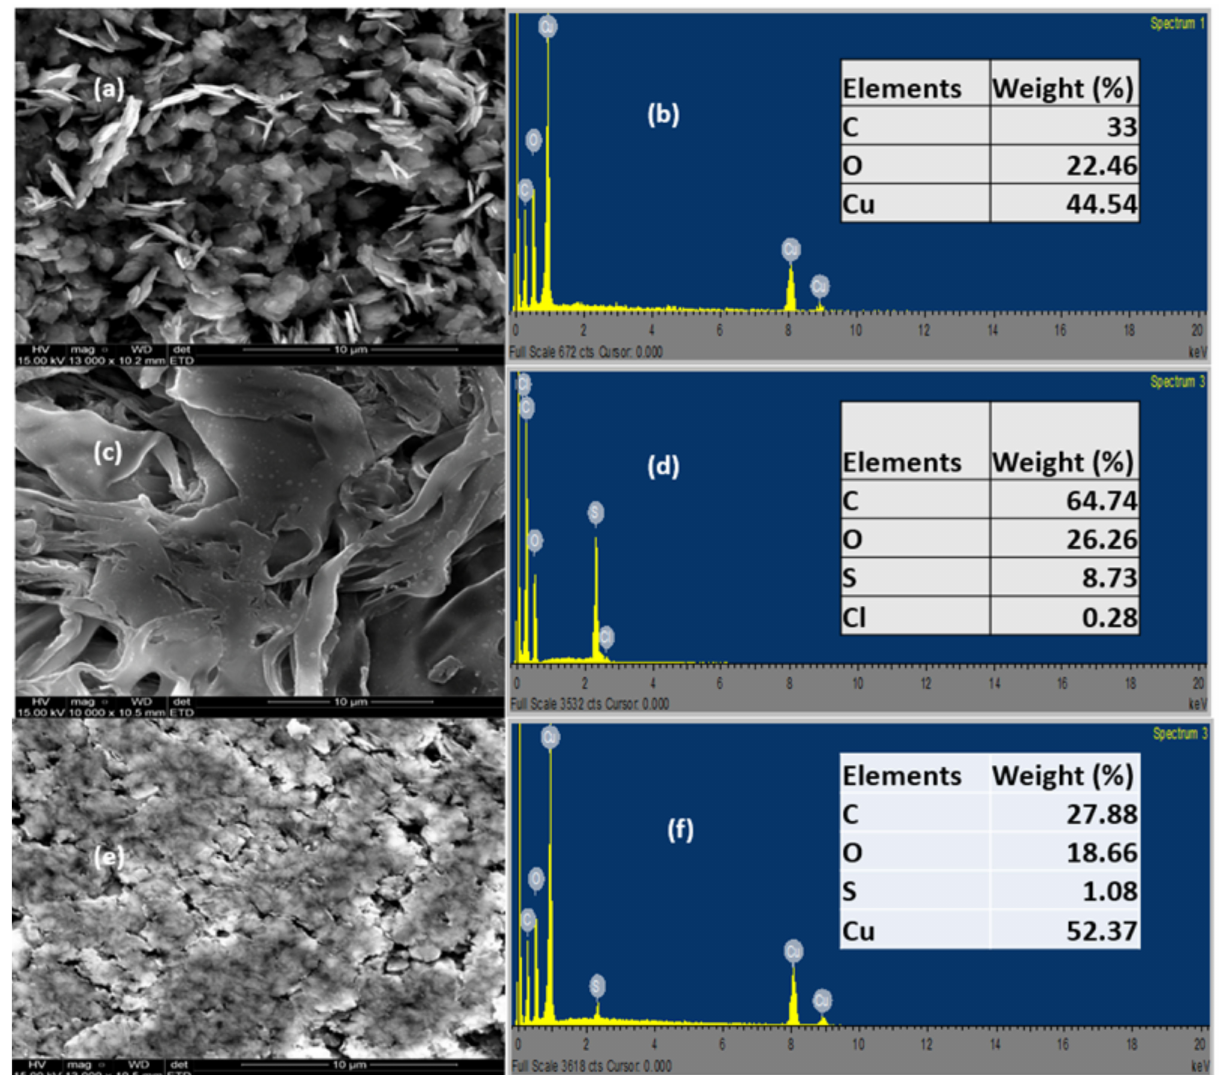
Figure 4. SEM images ( a , c , e ) and EDX analysis ( b , d , f ) for the CuO NPs, SPEEK, and SPEEK/CuO nanocomposite,